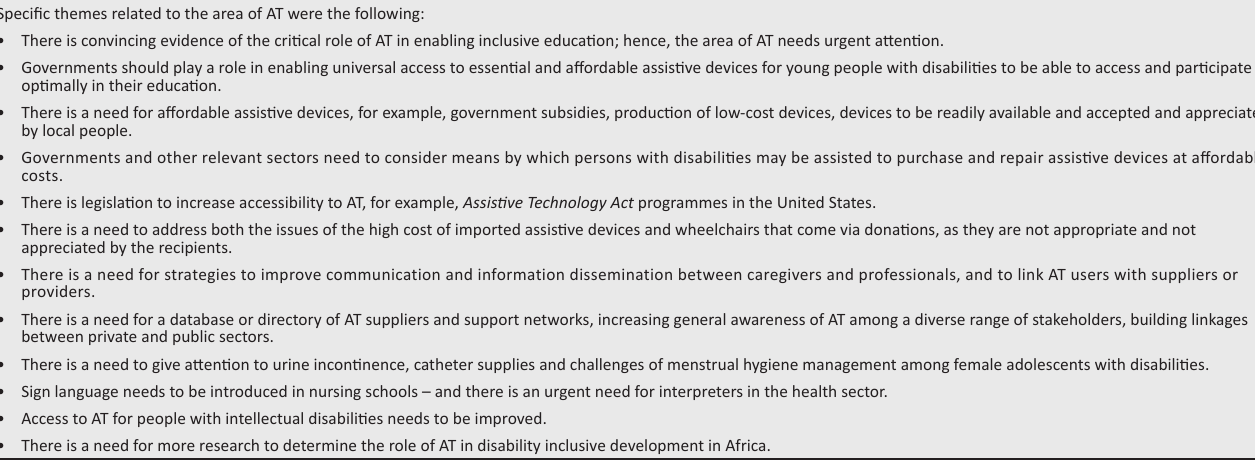
TABLE 1: Key themes related to AT at the fifth African Network for Evidence-to-Action in Disability conference. Specific themes related to the area of AT were the